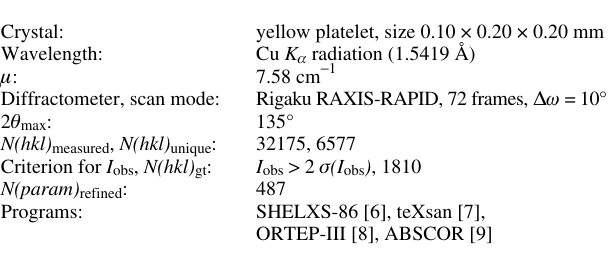
Table 1. Data collection and